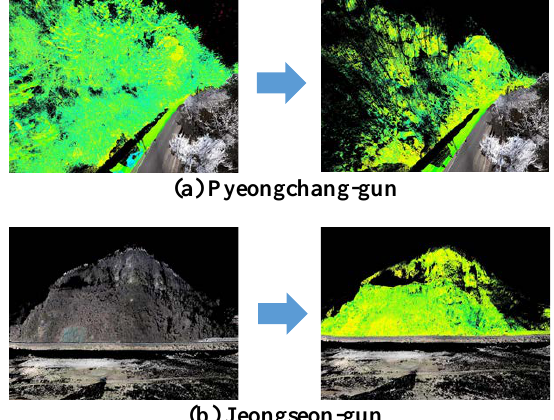
Figure 5. Before and after vegetation